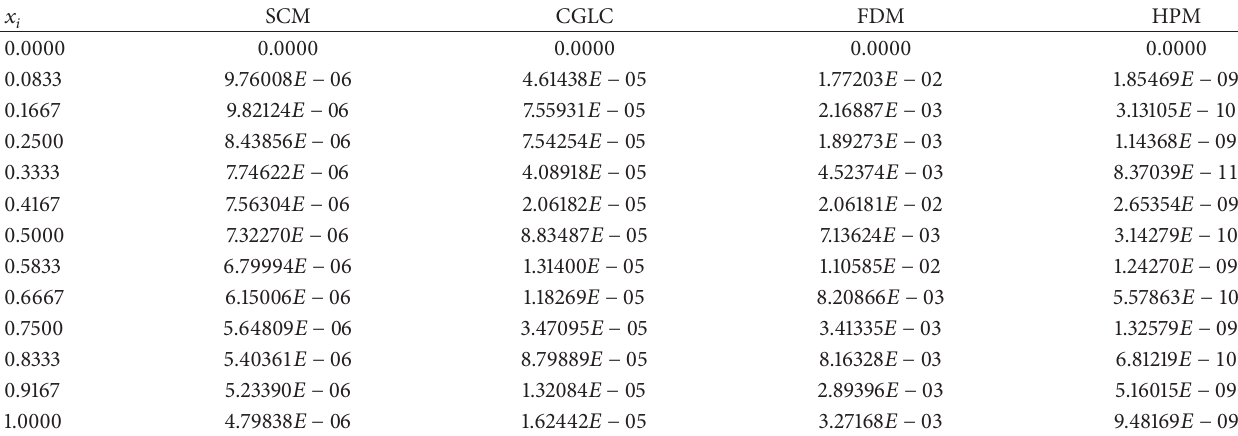
Table 4: Comparison of absolute errors for Problem